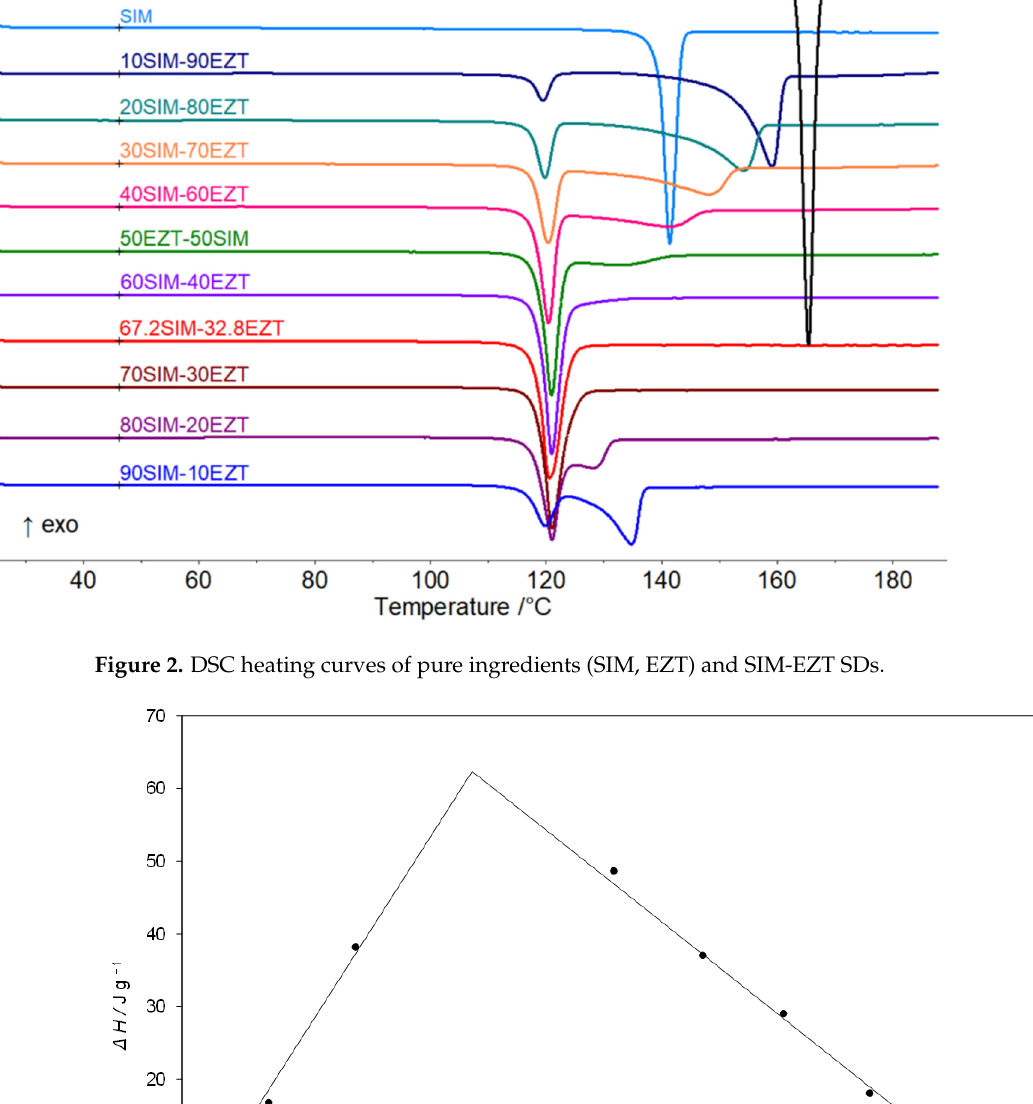
Figure 4. Phase diagram of SIM-EZT system. 3.3. XRPD Studies The SIM and EZT XRPD patterns and those received for SIM-EZT SDs are presented in Figure 5. A lot of distinct reflections indicating the crystalline nature of the investigated powders can be observed on the pure APIs and SDs patterns. The XRD reflections were visible on the SIM pattern at 2 θ diffraction angles of 7.8°, 9.4°, 10.9°, 15.0°, 17.2°, and 22.5° and the EZT pattern at 8.2°, 13.6°, 13.8°, 16.4°, 18.6°, 19.0°, 20.1°, 22.3°, 23.5°, 25.5°, 28.0°, and 29.7° were also present on the analyzed SIM-EZT patterns at the same angular posi-